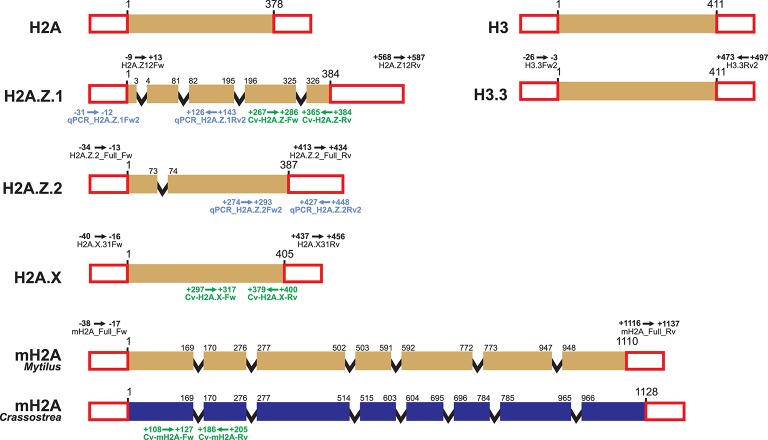
Schematic representation of bivalve histone gene structure and primer annealing positions. Histone genes H2A, H2A.Z.1, H2A.Z.2, H2A.X, macroH2A, H3, and H3.3 are represented using the mussel Mytilus as model species. Variations in length and intron/exon composition can be present in other bivalve species, such as the case of macroH2A in the oyster Crassostrea. Colored boxes represent coding exons, red uncolored boxes represent exons from UTR regions, and black lines represent introns (length not proportional to actual size). Details of PCR primers annealing in UTR regions (including name and annealing positions, see Table 1) are indicated above the corresponding histones. Details corresponding to qPCR primers (see Table 2) are indicated below each gene for the mussel Mytilus californianus (blue) and the Eastern oyster Crassostrea virginica (green).